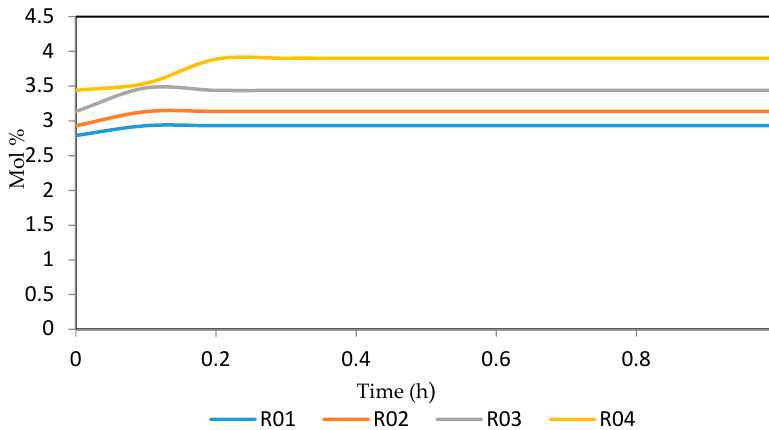
Figure 15. Dynamic behaviour of P 5 in the four reactors.